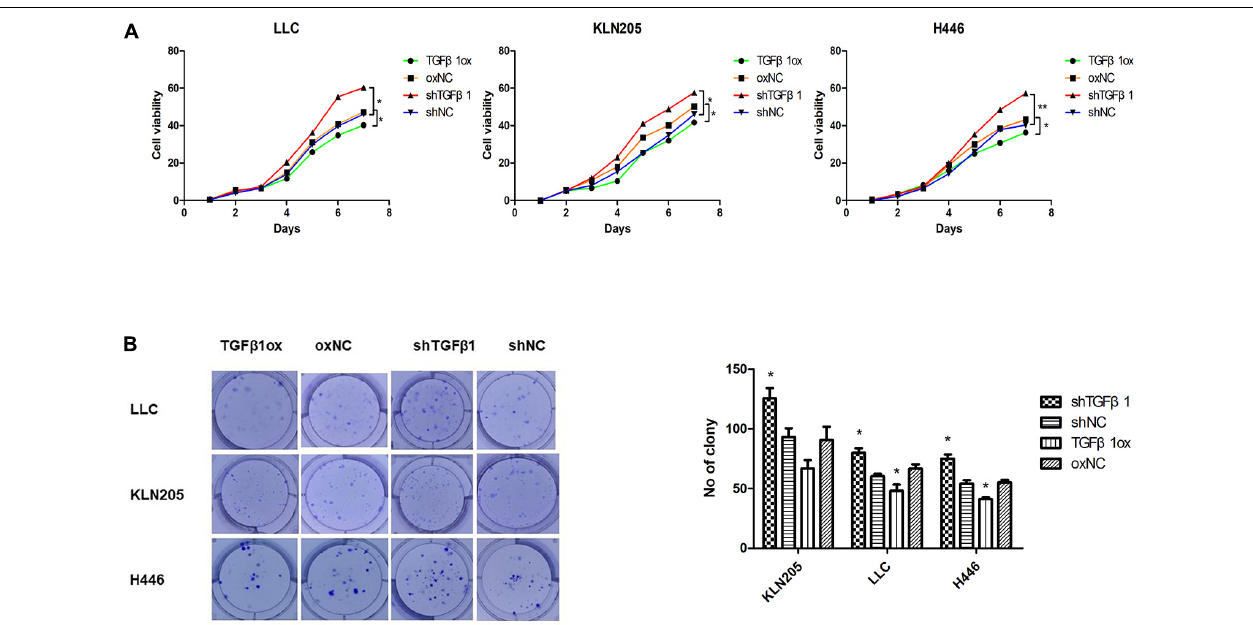
FIGURE 3 | The impact of TGF β 1 level produced by CAFs on lung cancer cell proliferation. (A,B) TGF β 1-knocked down CAFs promoted lung cancer cells viability and proliferation. Cell viability and proliferation were examined by CCK-8 assay and clonogenic survival assay, TGF β 1- overexpression CAFs enhanced the viability and proliferation of lung cancer cells. Statistical significance is shown ( ∗ p < 0.05; ∗∗ p < 0.01). shNC and oxNC, control groups corresponding to knockdown and overexpression of TGF β 1 recombinant lentiviral infection; shTGF β 1 and TGF β 1ox, knockdown and overexpression of TGF β 1 recombinant lentiviral infection; LLC, Lewis lung cancer cell; KLN205, mouse squamous cell lung cancer cell; H446, human small cell lung cancer